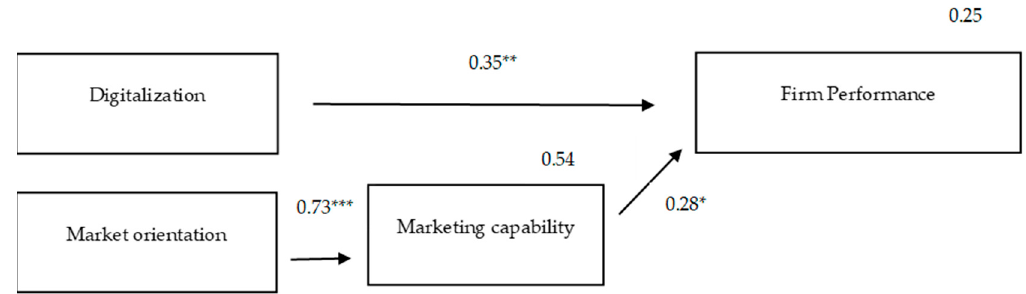
Figure 3. Standardized values for the tested model with firms operating only in their domestic markets. *, **, *** indicates significance at the 90%, 95%, and 99% level, respectively.